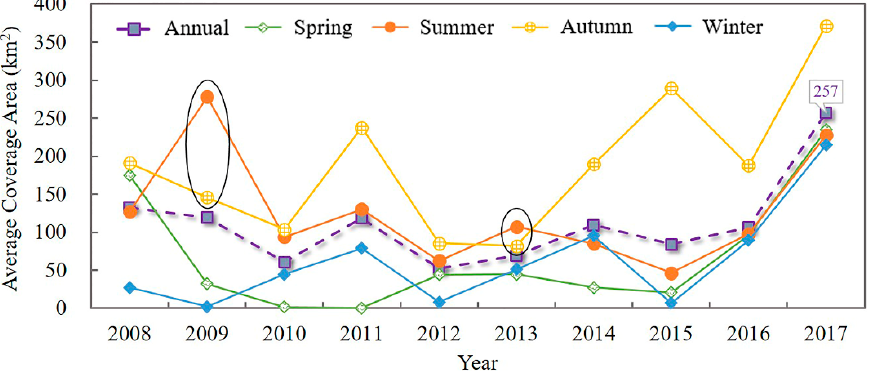
Figure 8. Average seasonal / annual algal bloom coverage area for Taihu Lake during 2008 – 2017.